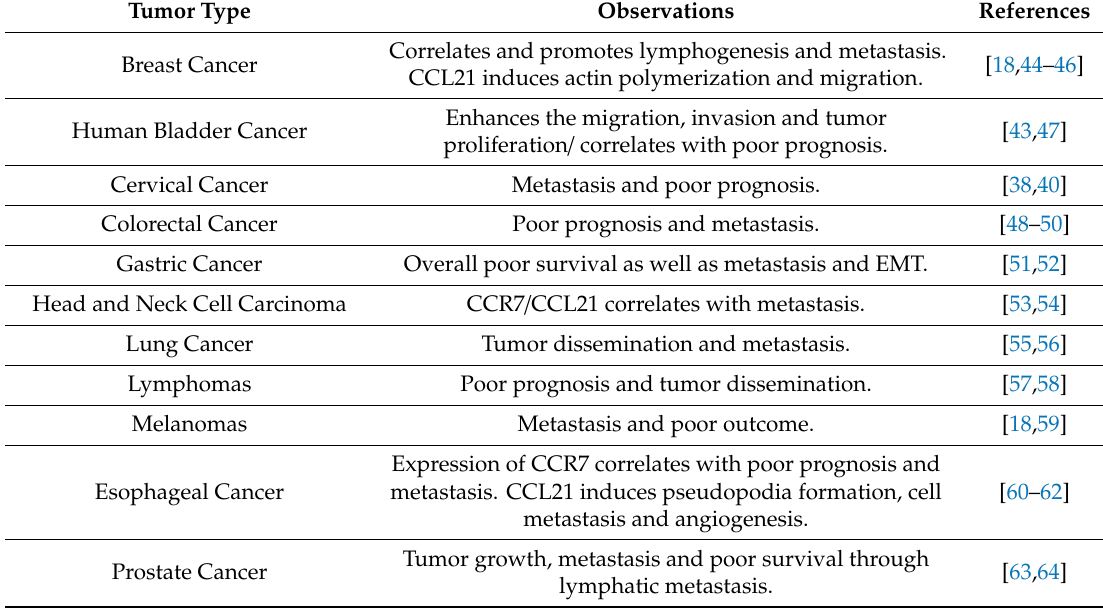
Table 1. The roles of C-C Chemokine receptor 7 (CCR7) / CCL21 in various human cancers. Tumor Type